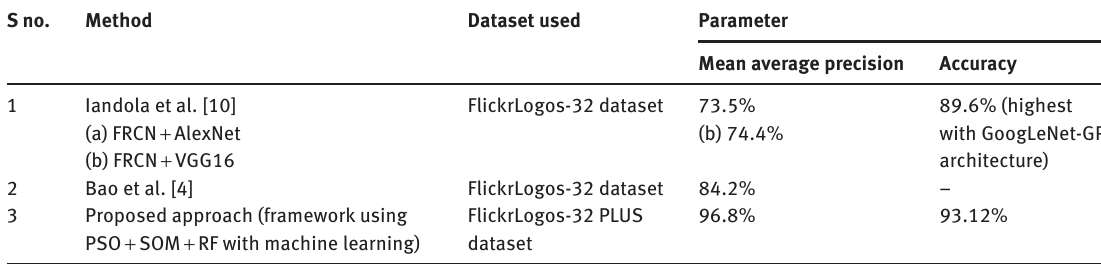
Table 8: Comparison for Iandola et al. [10] and Bao et al. [4] with the Proposed Approach. S no.